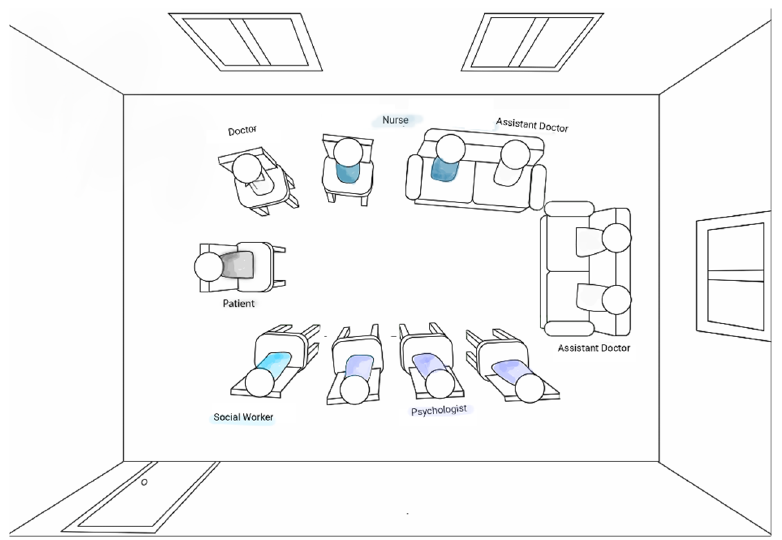
Figure 2. Interprofessional psychiatric consultation in meeting room with patient (Ward B).